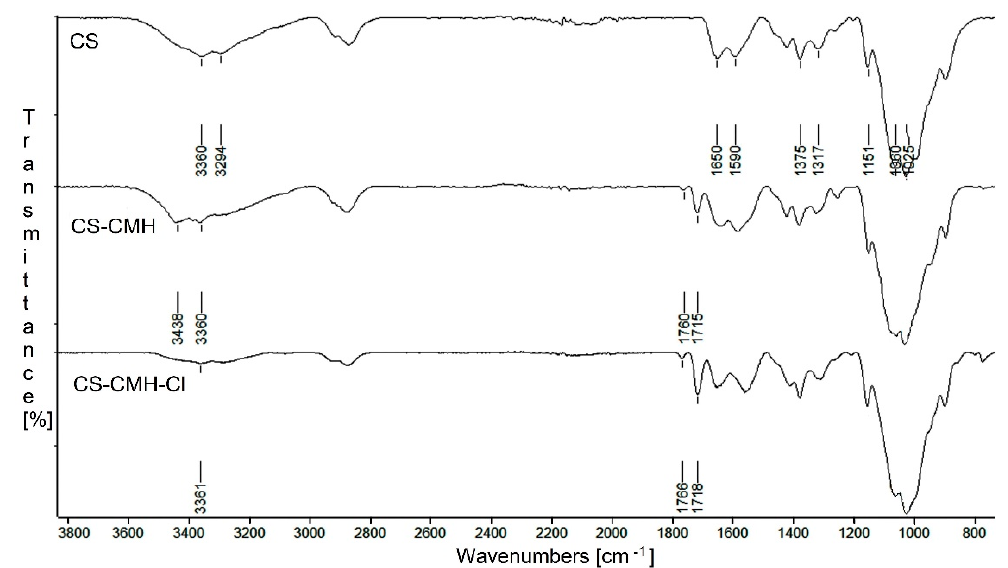
Figure 2. FTIR spectra of CS, CS-CMH and CS-CMH-Cl.